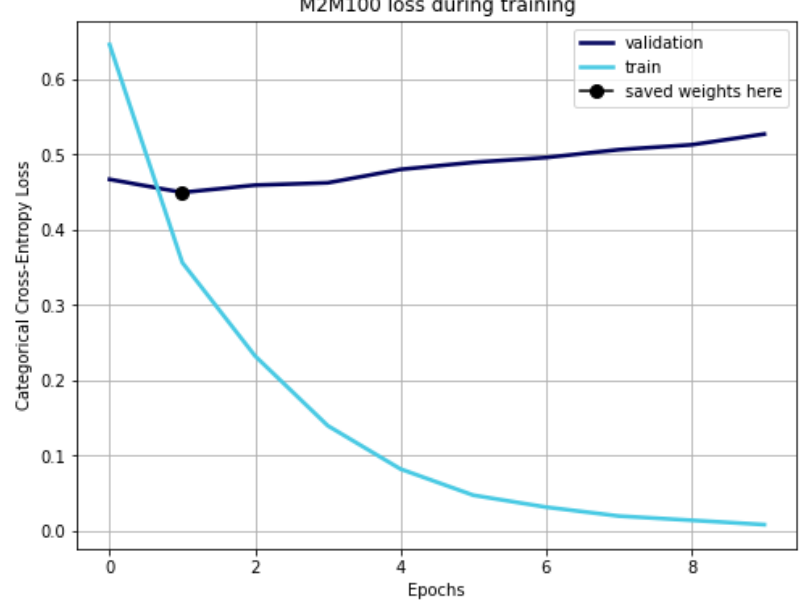
Figure 8. Curve of loss function during training НМ.